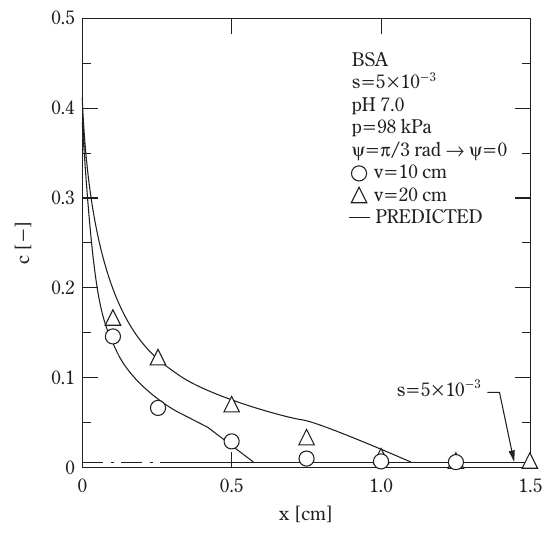
Fig. 14 Distribution of solute concentration in filter cake for dif- ferent filtrate volumes.